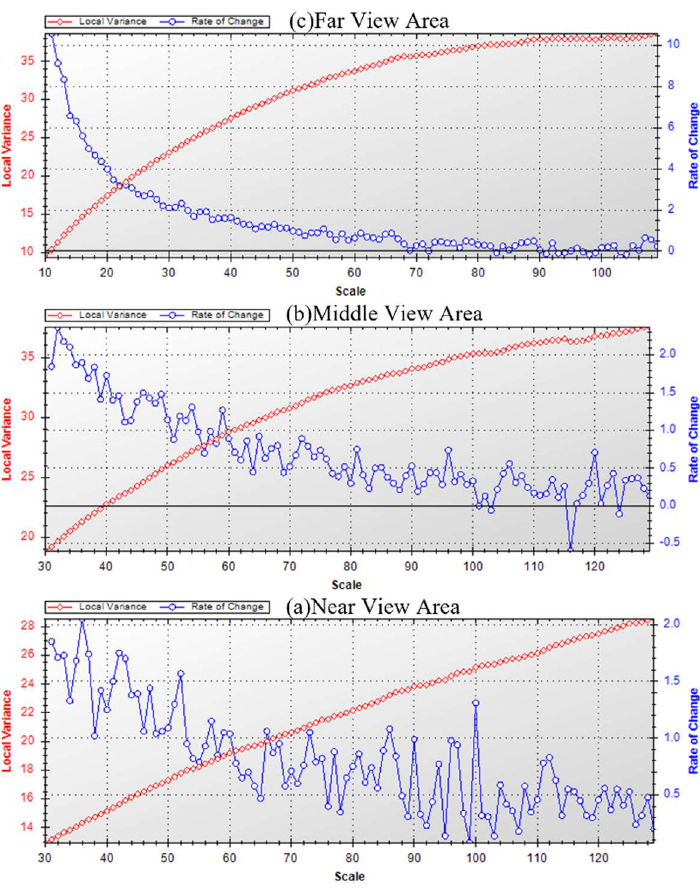
Figure 4. ROC−LV diagrams for near, middle and far view regions. Figure 4. ROC − LV diagrams for near, middle and far view Table 4. Optimal segmentation parameters for near, middle and far view regions.